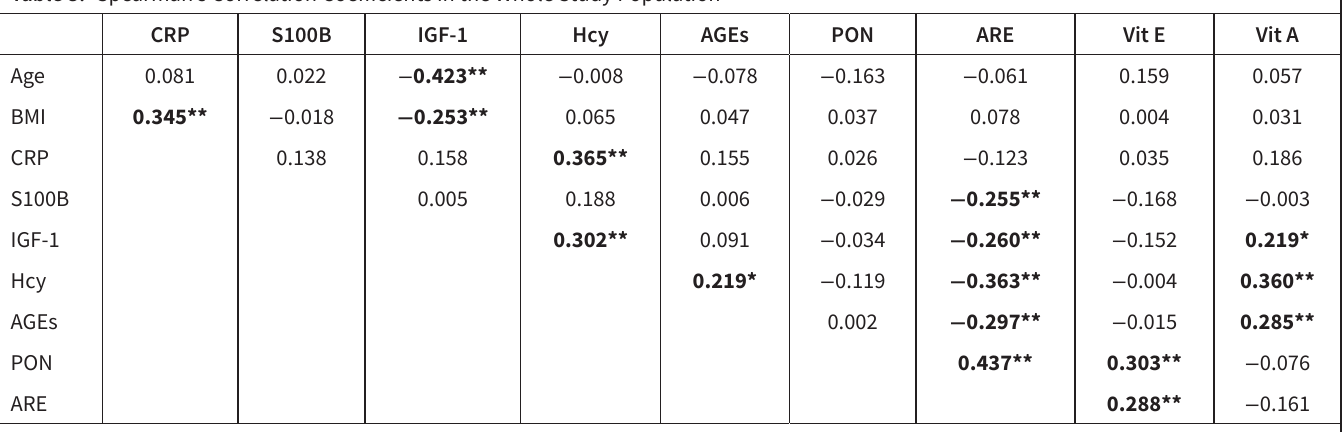
Table 3. Spearman’s Correlation Coefficients in the Whole Study Population